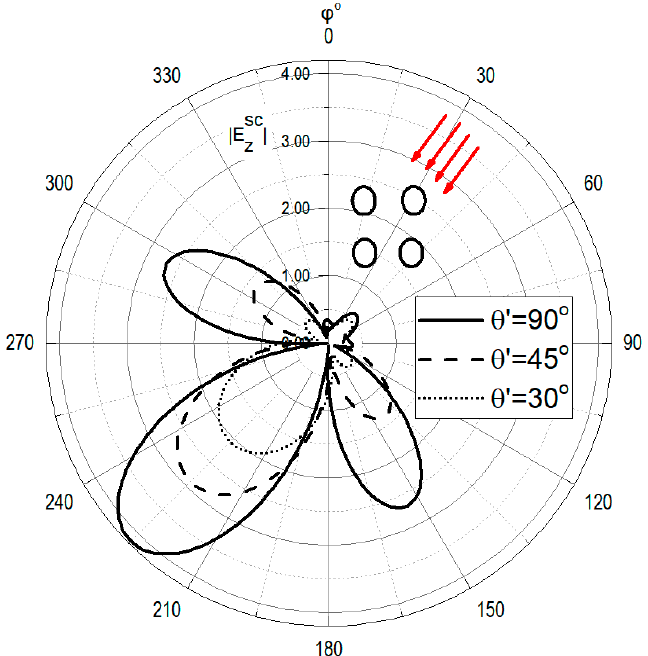
Figure 8. The normalized total scattering cross section (k 0 σ t ) versus ϕ (cid:48) for the inset structure, arising from that of Figure 1 when L = 3, ε 1 = ε 0 , D 23 = λ 0 , ε 2 = ε 4 = 4.34 ε 0 , ε 3 = ε 5 = 9.6 ε 0 , α 3 = α 5 = 0.1 λ 0 , µ σ i = 0 ( i = 1,2,3,4,5) and α 2 = α i 0 , H 0 = 1 and θ (cid:48) = 75 ◦ .